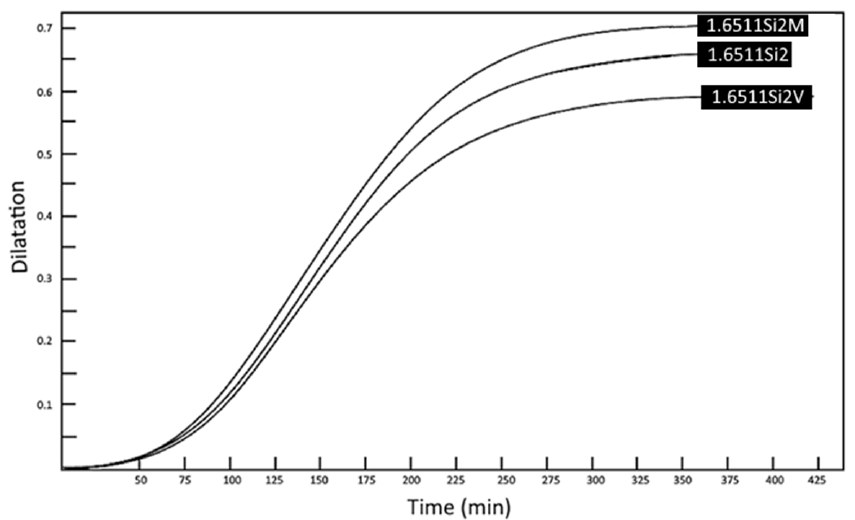
Figure 6. Isothermal dilatometry graph of 1.6511Si2, 1.6511Si2V, and 1.6511Si2M at 300 °C. Note: Transformation cessation is delayed by adding rare earth elements, but vanadium caused it to occur sooner.